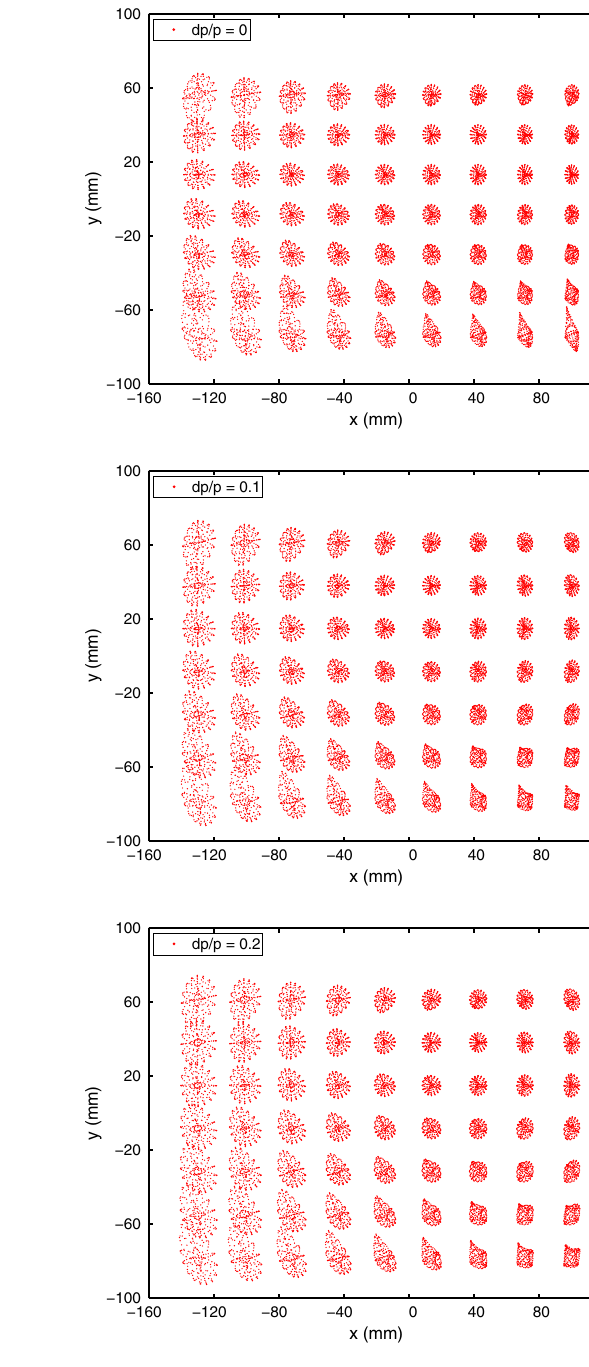
FIG. 20. Grid scans with minimal correction for Δ p=p ¼ − 5% , 0%, +5%, +10%, +15%, +20%. Note the rectangular grid size of 23 cm × 10 cm for Δ p=p ¼ − 5% and 23 cm × 14 cm for Δ p=p ≥ 0%